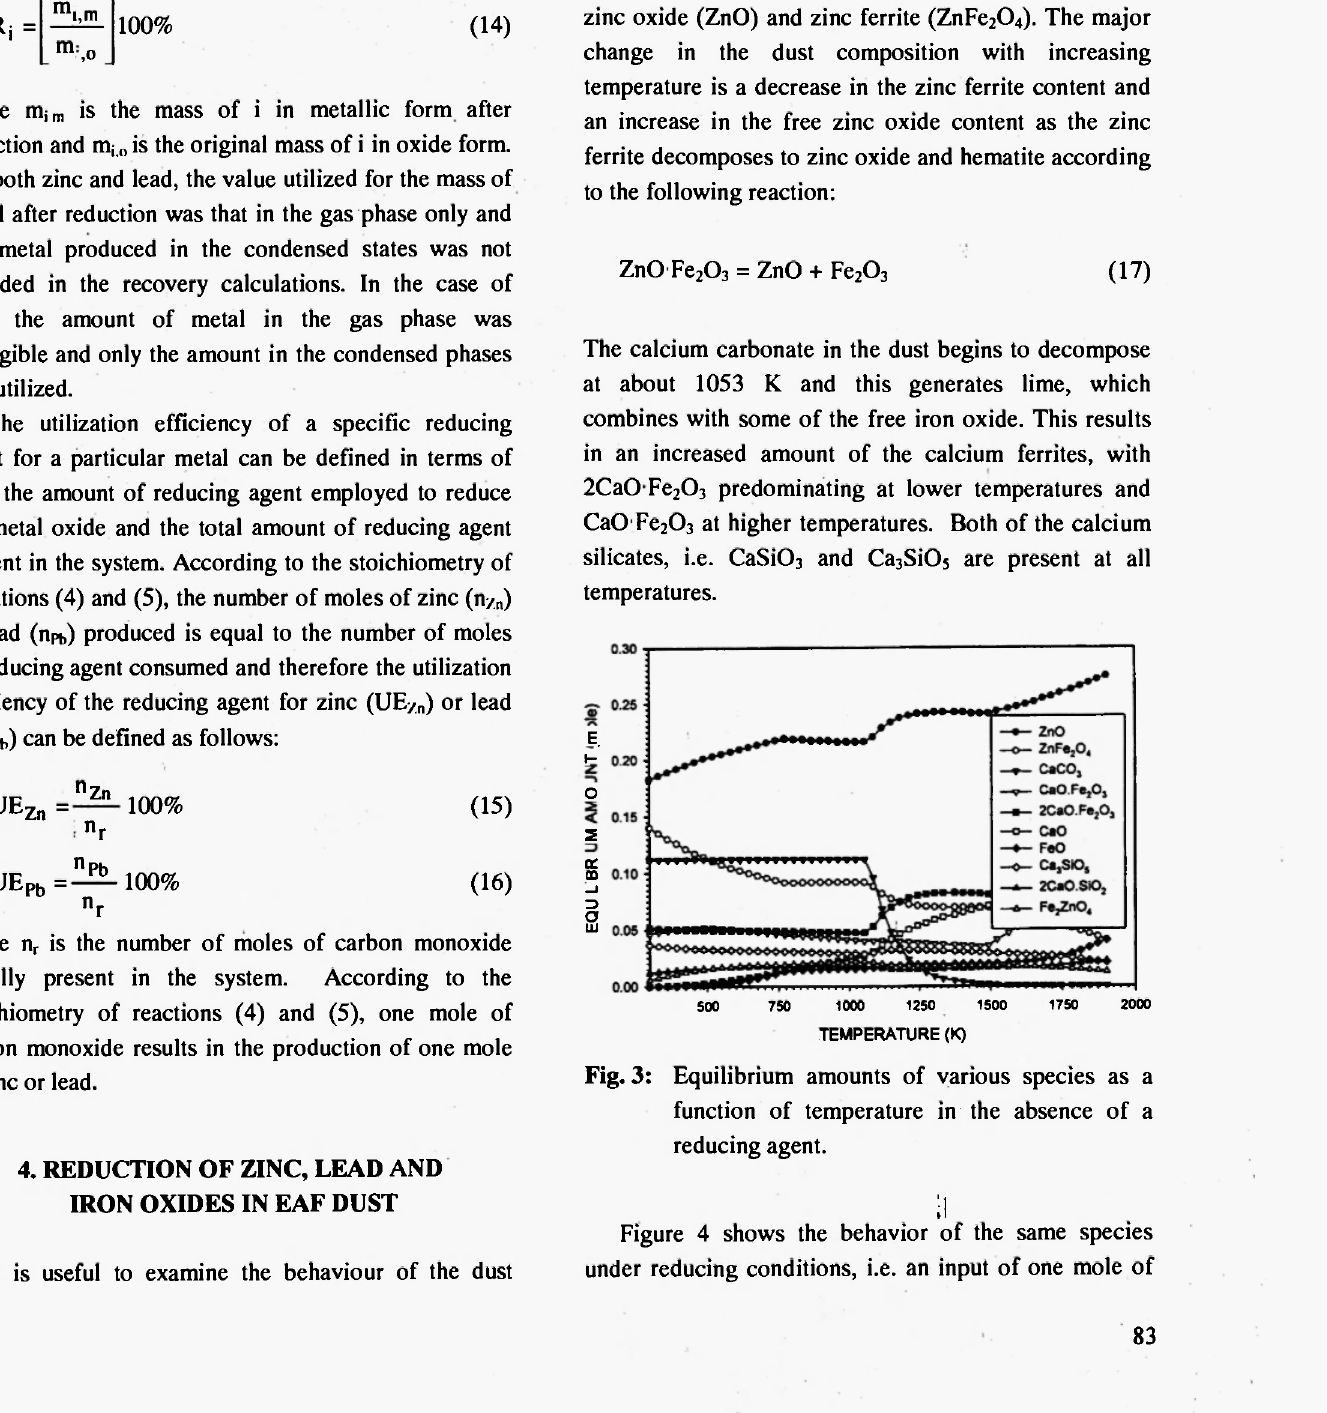
Fig. 3: Equilibrium amounts of various species as a function of temperature in the absence of a reducing